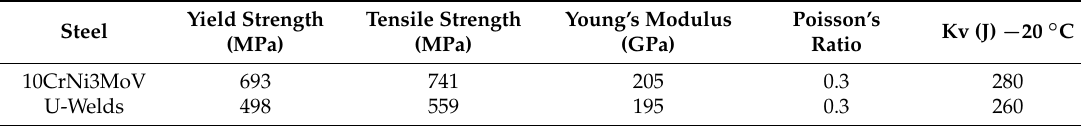
Figure 3. Monotonic stress-strain curves of 10CrNi3Mov high strength steel and its undermatched welds. Table 3. Mechanical properties of test materials.